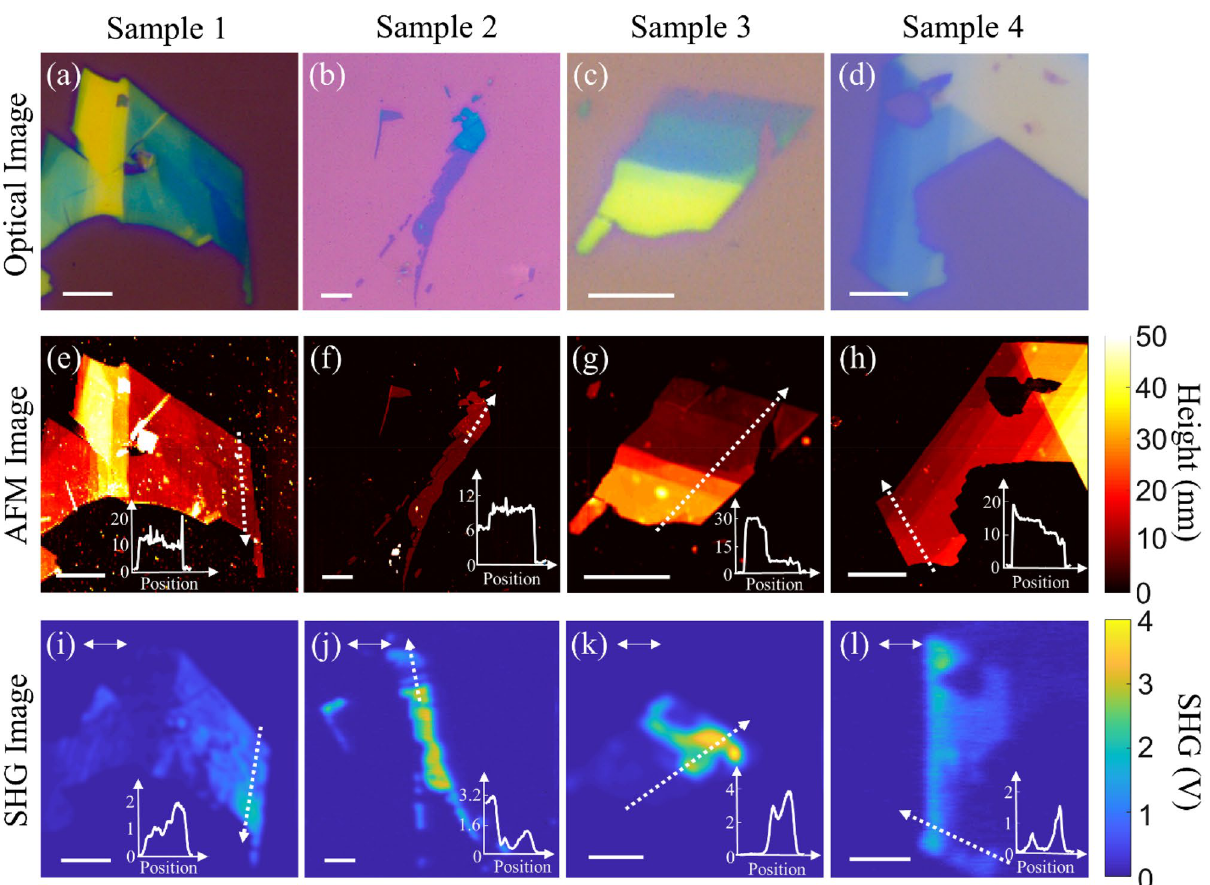
Figure 2. Summary of images acquired for four different 2H SnSe2 samples using different imaging modalities. ( a – d ) optical reflectance images, ( e – h ) AFM image and ( i – l ) SHG image with incident light polarized along the arm-chair axis. Each line-scan shown in the inset of AFM and SHG image are along the white dashed line marked in the images with arrow points the direction of the line-scan. Scale bar shown in all images is 5 μm. The double-headed arrows shown in the SHG Images correspond to the incident polarization direction. (Created in MATLAB v9.6, R2019a, https:// in. mathw orks.